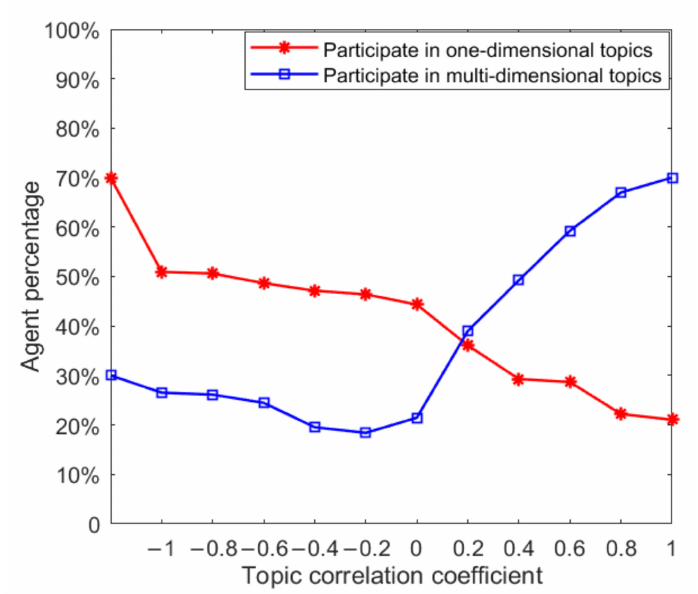
Figure 6. The influence of opinion leaders on the number of topics that individuals participate in under different topic correlation coefficients.